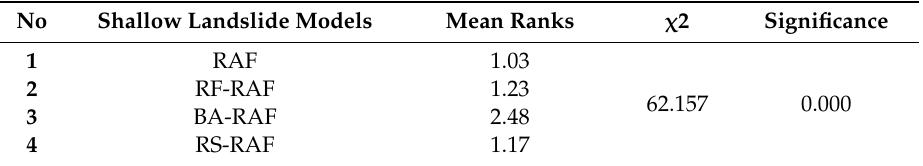
Table 5. Performance of the shallow landslide models based on the Friedman’s test. No Shallow Landslide Models Mean Ranks χ 2 Significance